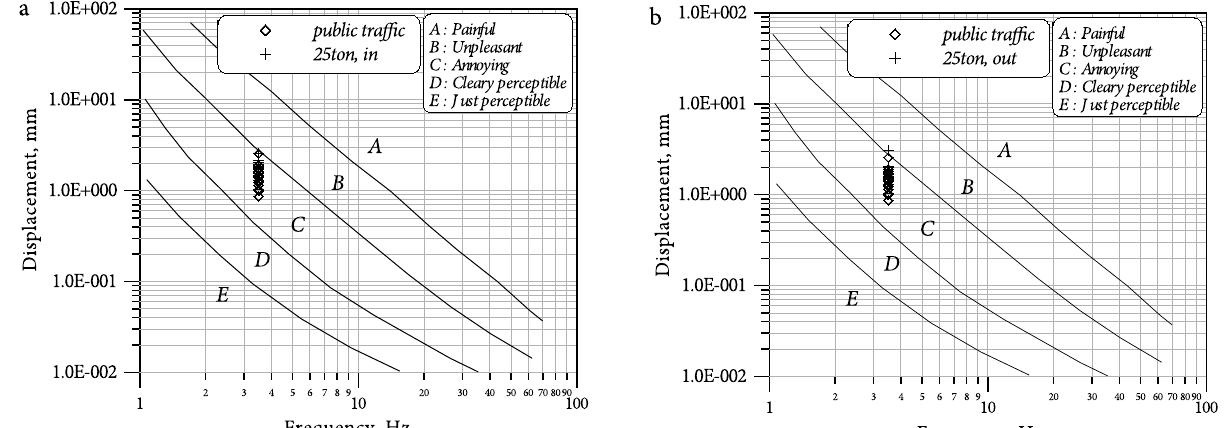
Fig. 10. Comparison with public traffic and test-vehicle (displacement): a – in; b –